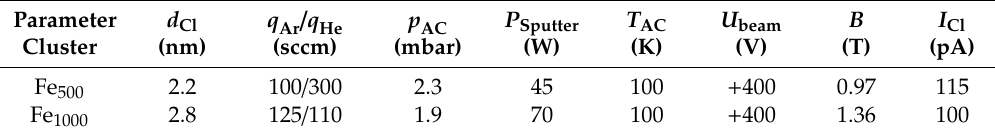
Table 1. Exemplary process parameters for the two cluster species with diameter d Cl . Ar & He